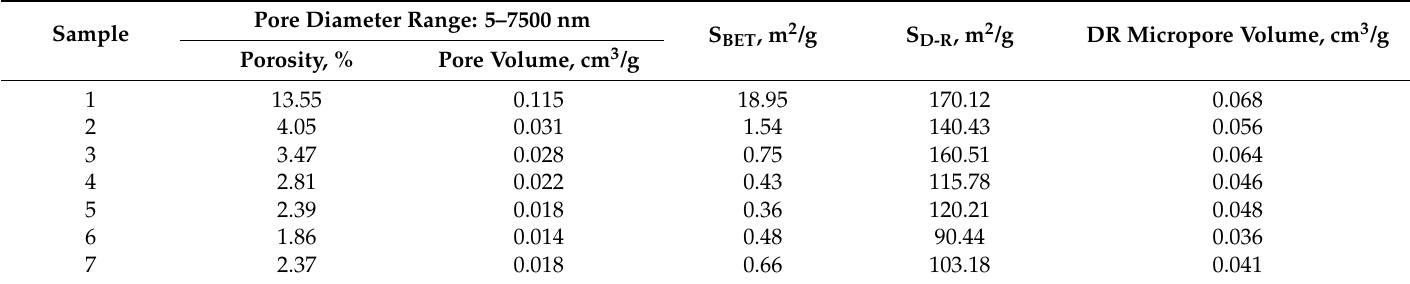
Table 2. Porosity and pore volume determined with the application of mercury porosimetry, specific surface area determined with the application of nitrogen